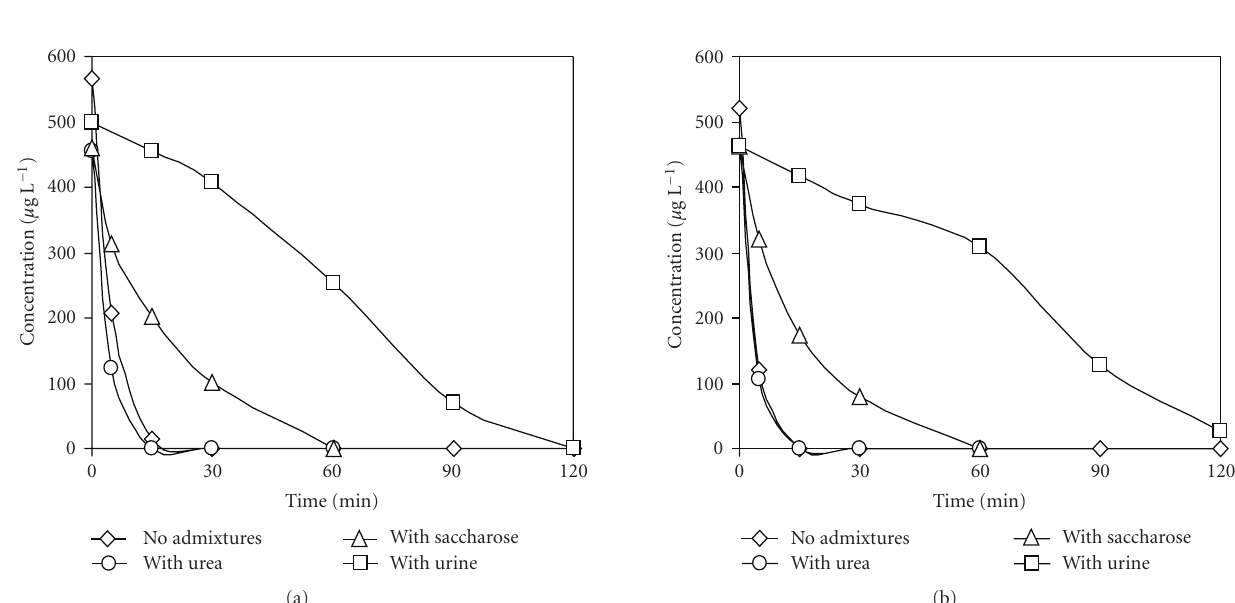
Figure 6: The rate of PCO of E2 (a) and EE2 (b) at pH 11 under di ff erent admixture conditions: 75 mg L − 1 of urea, 50 mg L − 1 of saccharose, 10 mL L − 1 of